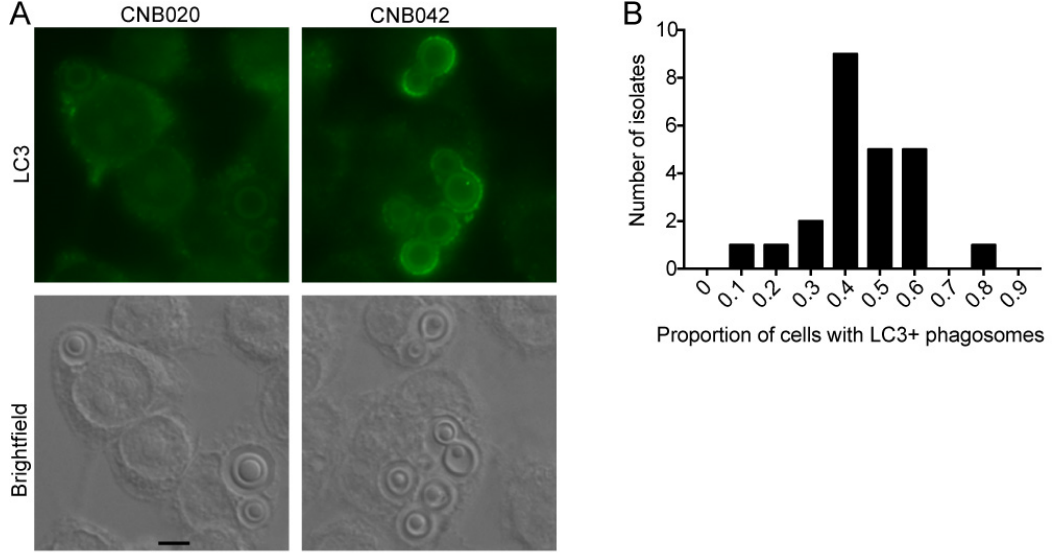
Figure 3. Interaction of clinical isolates with macrophages in LC3-associated phagocytosis (LAP). Representative photo of the autophagy assessment by immunofluorescence, measured by means of LAP. ( A ) Clinical isolate CNB020 with low LAP induction and CNB042 with high LAP induction, as examples. ( B ) Frequency distribution of the proportion of J774 cells in which all phagocytosed fungi were contained within LC3-positive phagosomes among all macrophages with at least one internalized yeast cell, n = 24. Experiments were repeated at least twice in different days and had similar results. Scale bar: 10 μ m.